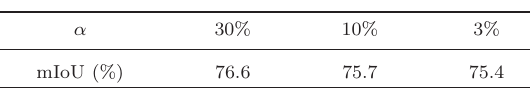
Table 4 Comparison of forms of KL divergence used as loss function Method Table 6 Effect of varying sampling density